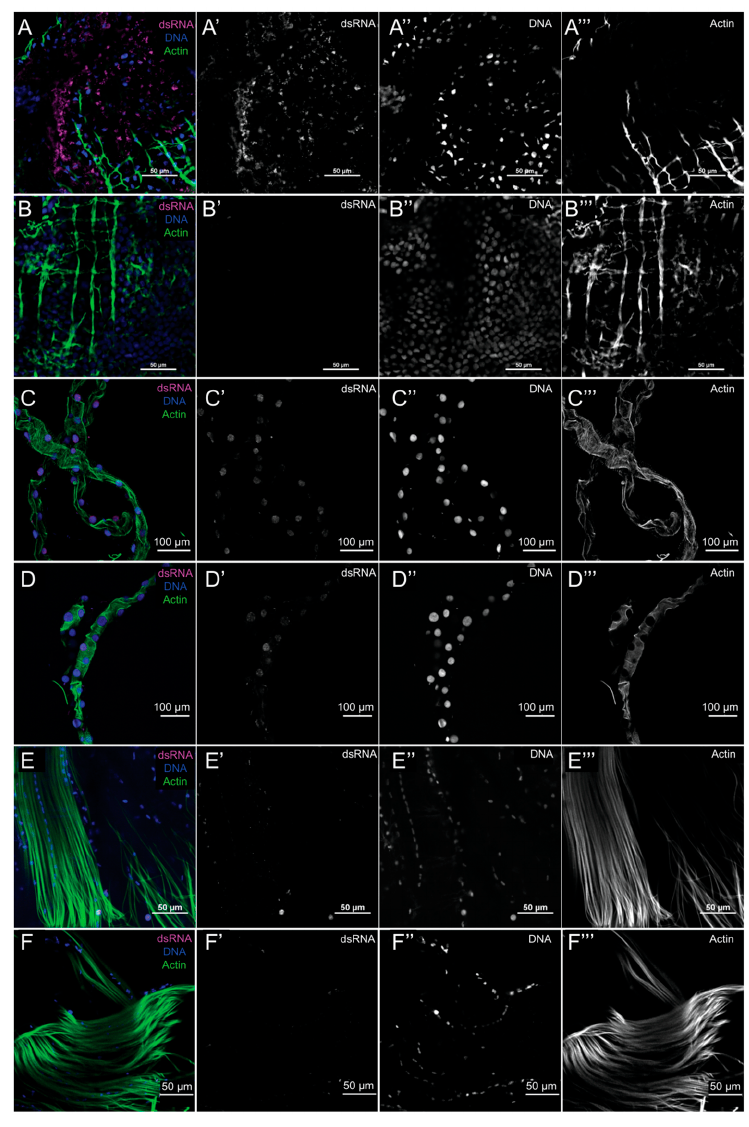
Figure 2. MAYV tissue tropism upon oral infection in Aedes aegypti . ( A ) MAYV is present in midgut epithelial enterocytes in BR-BH female mosquito 4 days after feeding on a blood meal containing 10 9 p.f.u. mL − 1 of MAYV. ( B ) Midgut from BR-BH female mosquito fed on blood only. ( C ) MAYV was not detected in the Malphigian tubules, in BR-BH female mosquito 4 days after feeding on a blood meal containing 10 9 p.f.u. mL − 1 of MAYV. ( D ) Malphigian tubules from BR-BH female mosquito fed on blood only. ( E ) MAYV was not detected in the thorax muscle in BR-BH female mosquito 4 days after feeding on a blood meal containing 10 9 p.f.u. mL − 1 of MAYV. ( F ) Thorax muscle from BR-BH female mosquito fed on blood only. A, B, C, D, E, F, are images merging the triple-staining of the immunefluorescence assays of adult female tissues that were immunostained with antibody against dsRNA (magenta), actin marked with phalloidin (green) and DNA marked with Hoechst (blue). A’, B’, C’, D’, E’, F’ correspond to dsRNA immunostaining. A’’, B’’, C’’, D’’, E’’, F’’ correspond to DNA staining. A’’’, B’’’, C’’’, D’’’, E’’’, F’’’ correspond to actin staining.